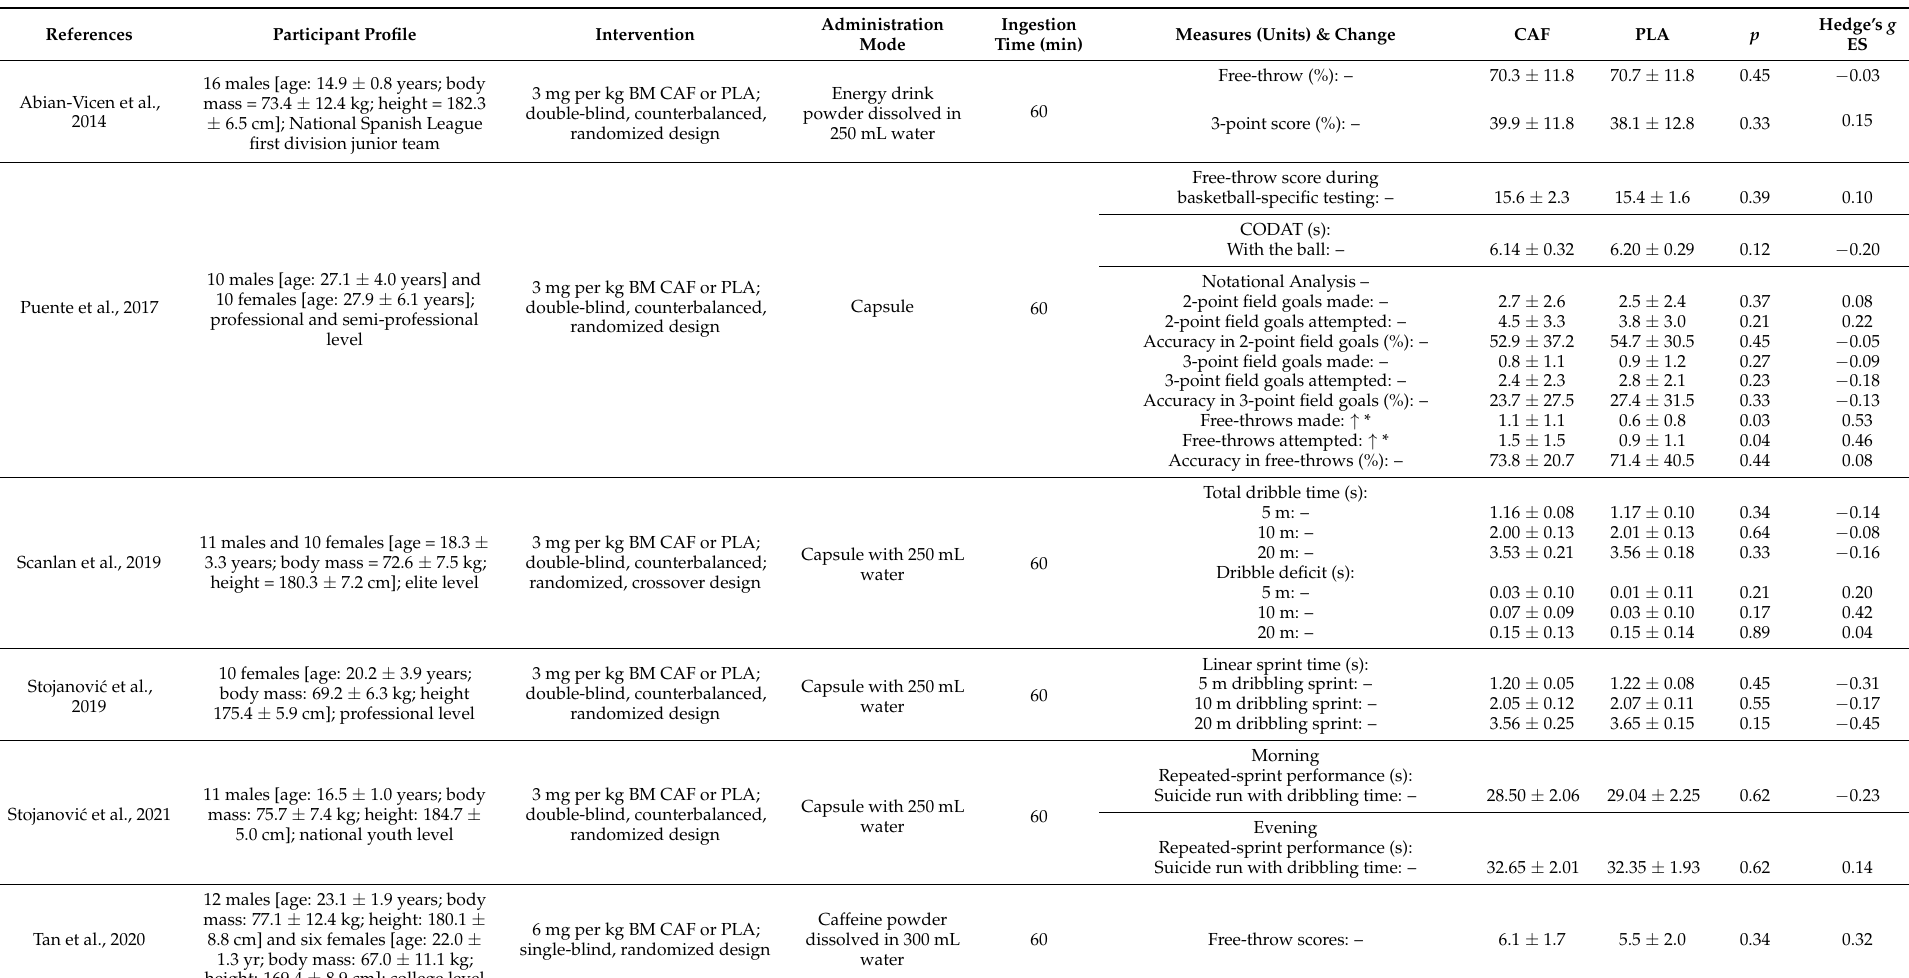
Table 2. Effect of caffeine supplementation on basketball skills